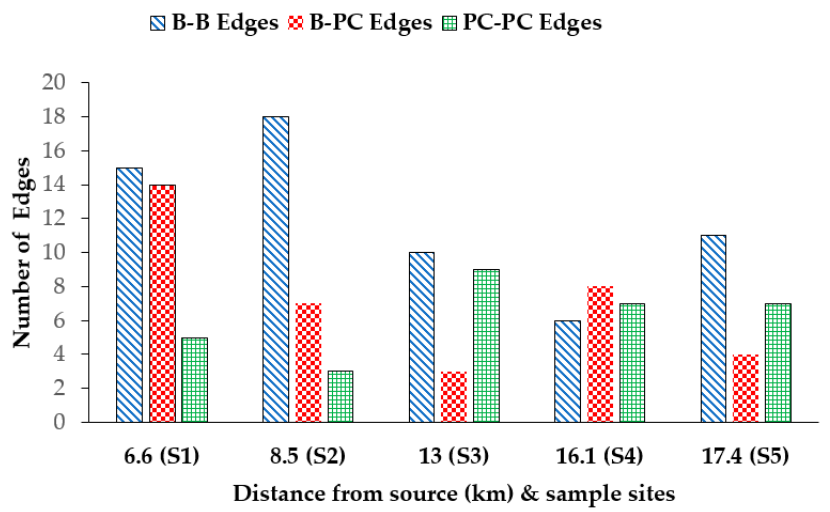
Figure 5. The number of edges observed between the variables per site for sites 1 to 5. With increasing distance from the river’s source, the number of edges decreased at the sites. B–B: biological—biological, B—PC: biological—physicochemical and PC—PC: physicochemical—physicochemical.